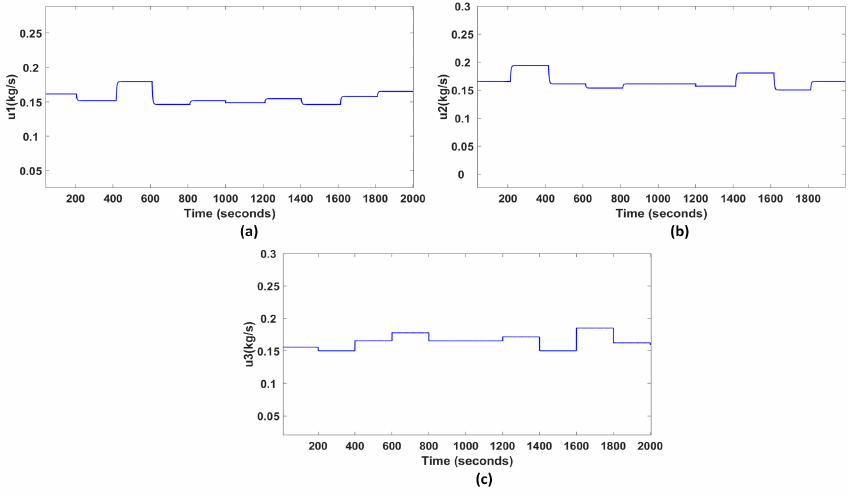
Figure 15. Control efforts: ( a ) u 1 , ( b ) u 2 and ( c ) u 3 by SMC for the combination of steps reference (Zone 1 and Zone